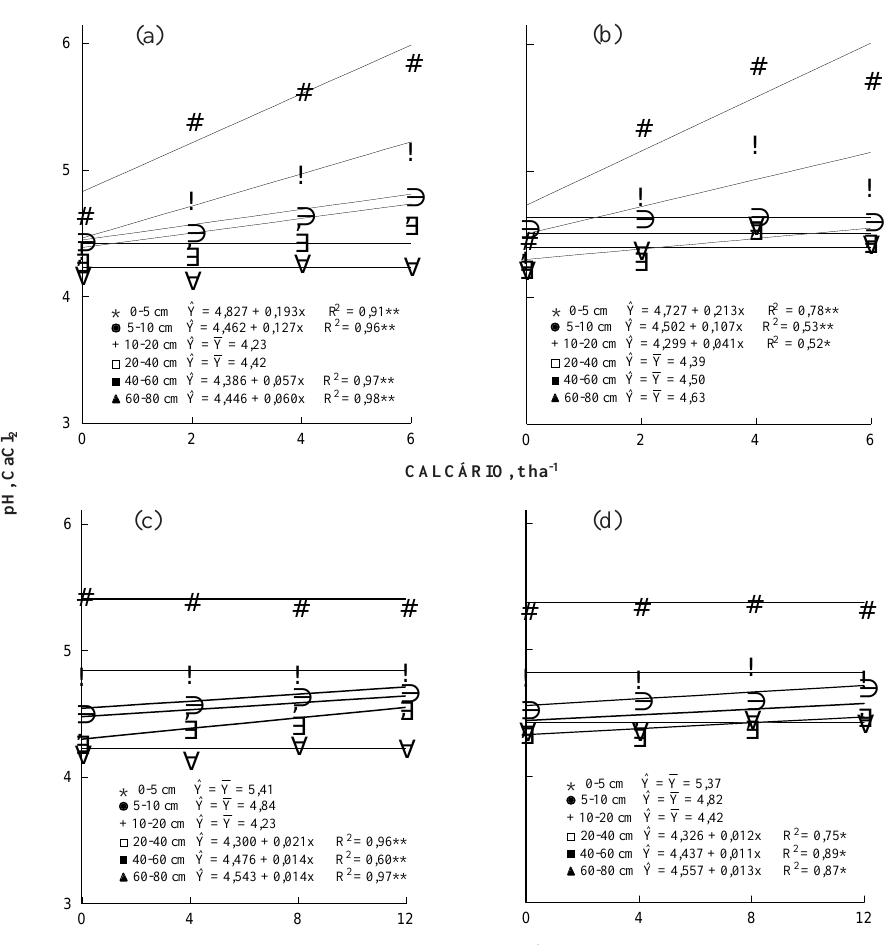
Figura 1. Efeito de doses de calcário, após 18(a) e 40(b) meses, e de gesso, após 14(c) e 36(d) meses, nos valores de pH, em diferentes profundidades. (a e b: médias de quatro doses de gesso; c e d: médias de quatro doses de calcário). *, ** significativos a 5 e 1%,